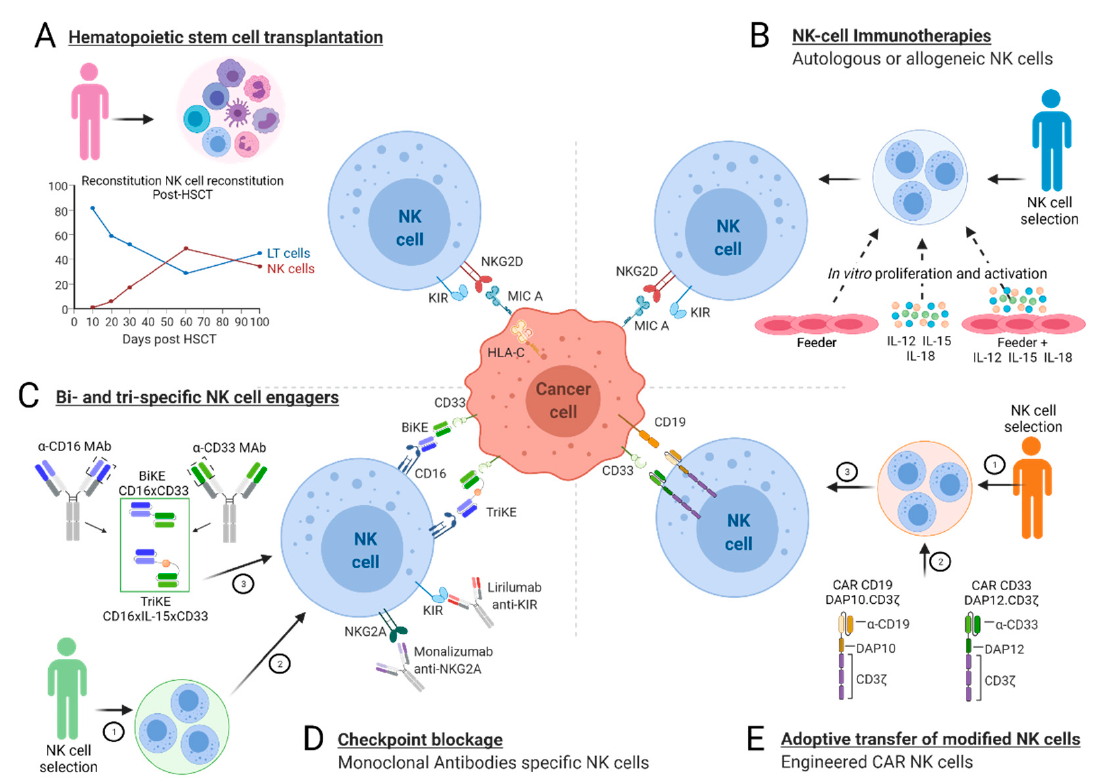
Figure 5. NK-cell-based immunotherapies for acute leukemia patients. Because of their antileukemic (GvL) effects, NK cells play a major role, as they are the first cells to reconstitute the recipient’s immune system after allogeneic hematopoietic stem-cell transplantation (HSCT) ( A ). Apart from HSCT, the efficiency of NK-cell based immunotherapies could be enhanced with the infusion of autologous or allogeneic NK cells that are activated in vitro using a feeder and/or specific cytokines ( B ). The use of bi- or tri-specific killer engagers (BiKEs, TriKEs) ( C ) or specific anti-NK cell receptor monoclonal antibodies (mAbs) ( D ) could also enhance the GvL function of NK cells. Adoptive transfer of engineered NK cells armed with chimeric antigen receptors (CARs) ( E ) is another emerging alternative.